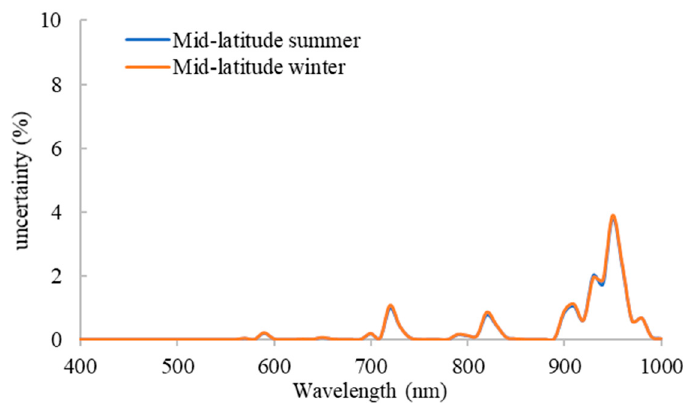
Figure 10. Uncertainty associated with downwelling irradiance (sun and sky) caused by a relative measurement uncertainty of 12% in the water vapor column (WVC).